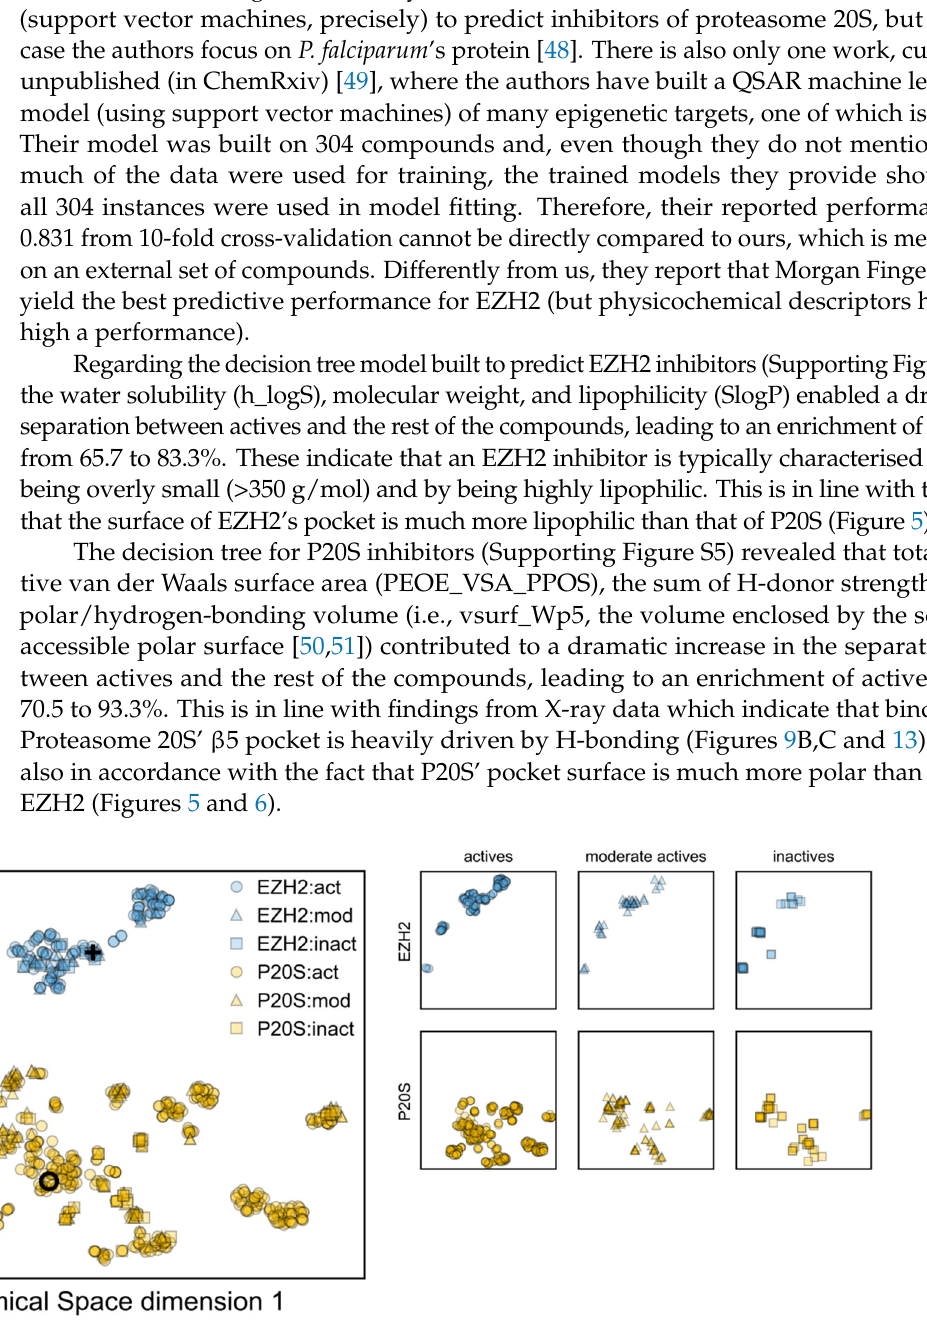
Figure 13. Chemical space of the EZH2 inhibitors dataset (blue) and the P20S inhibitors dataset (yellow). The black circle represents CHEMBL3794075 and the black cross marks CHEMBL3771372, the two hits originating from docking.